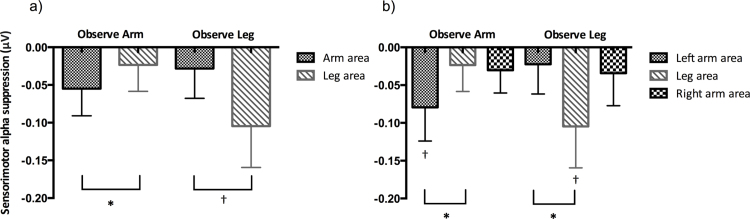
(a) Mean sensorimotor alpha suppression over the medial leg area and lateral arm areas during the observation of arm and leg movements in adult participants. (b) Mean sensorimotor alpha suppression over the left arm area, the leg area, and the right arm area during the observation of arm and leg movements in adult participants. Significant and marginally significant effects are indicated, *p < .05, †.05 < p < .1. Error bars represent 1 SEM.